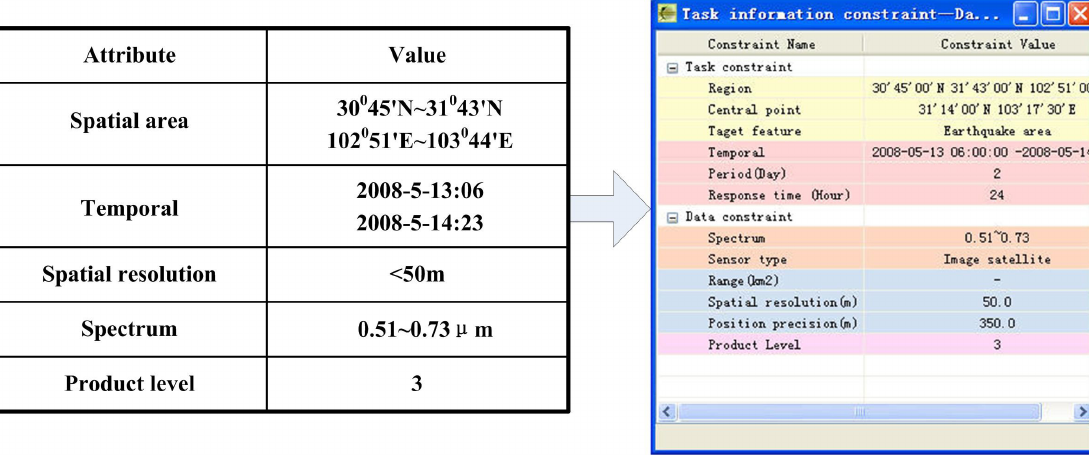
Figure 11. Task analyses and task